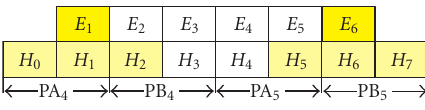
Figure 2: Concurrent windowing definition.